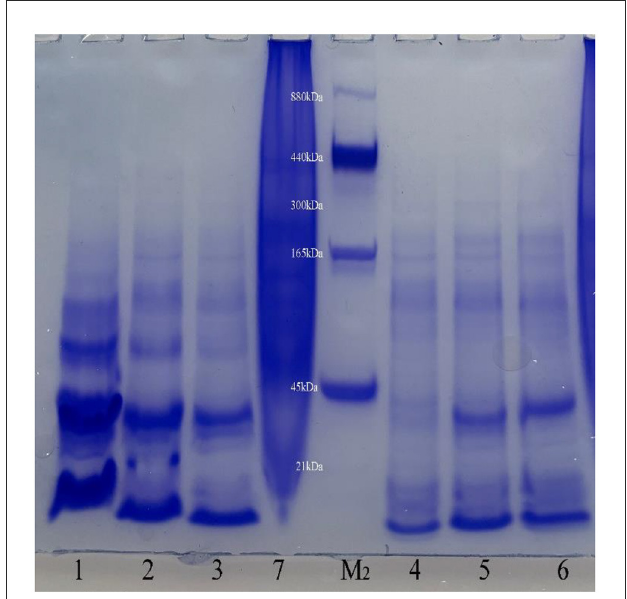
FIGURE4 Native Polyacrylamide gel electrophoresis results. Lane1, Purified sample of target protein from strain E. coli PC; Lane2, Purified sample of target protein from strain E. coli APC; Lane3, Purified sample of target protein from strain E. coli PC-APC; Lane4, Purified sample of target protein from strain E. coli PC-APC-HPUSTEF Protein purification sample; Lane5, Purified sample of target protein from strain E. coli PC-HPUSTEF; Lane6, Purified sample of target protein from strain E. coli APC-HPUSTEF; Lane7, Unpurified protein sample of control E. coli BL21; Lane M 2 , Native-PAGE Protein Marker.